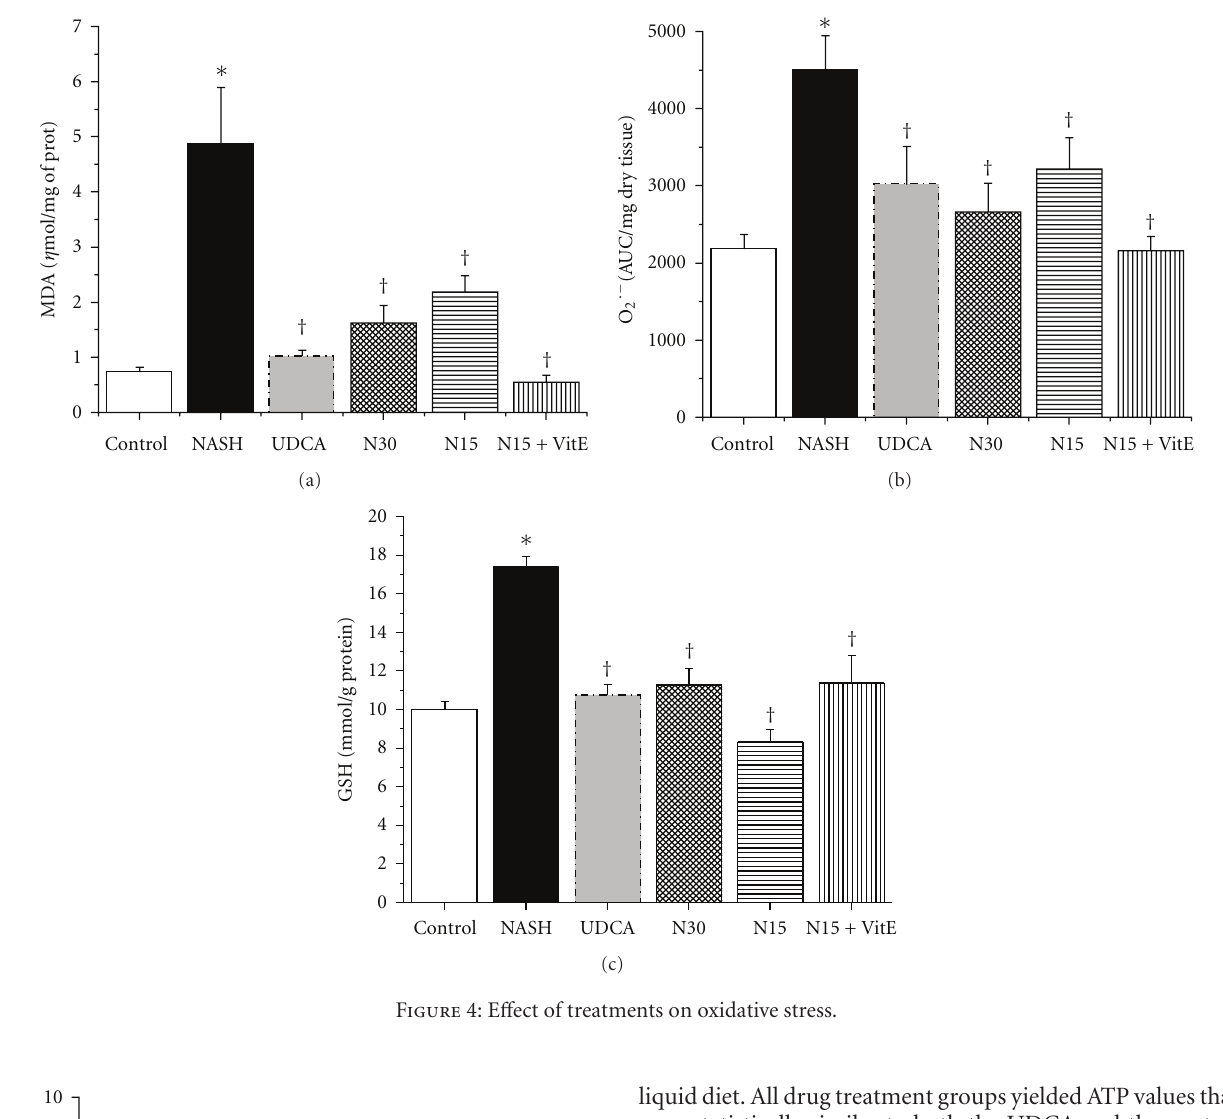
Figure 4: E ff ect of treatments on oxidative stress.